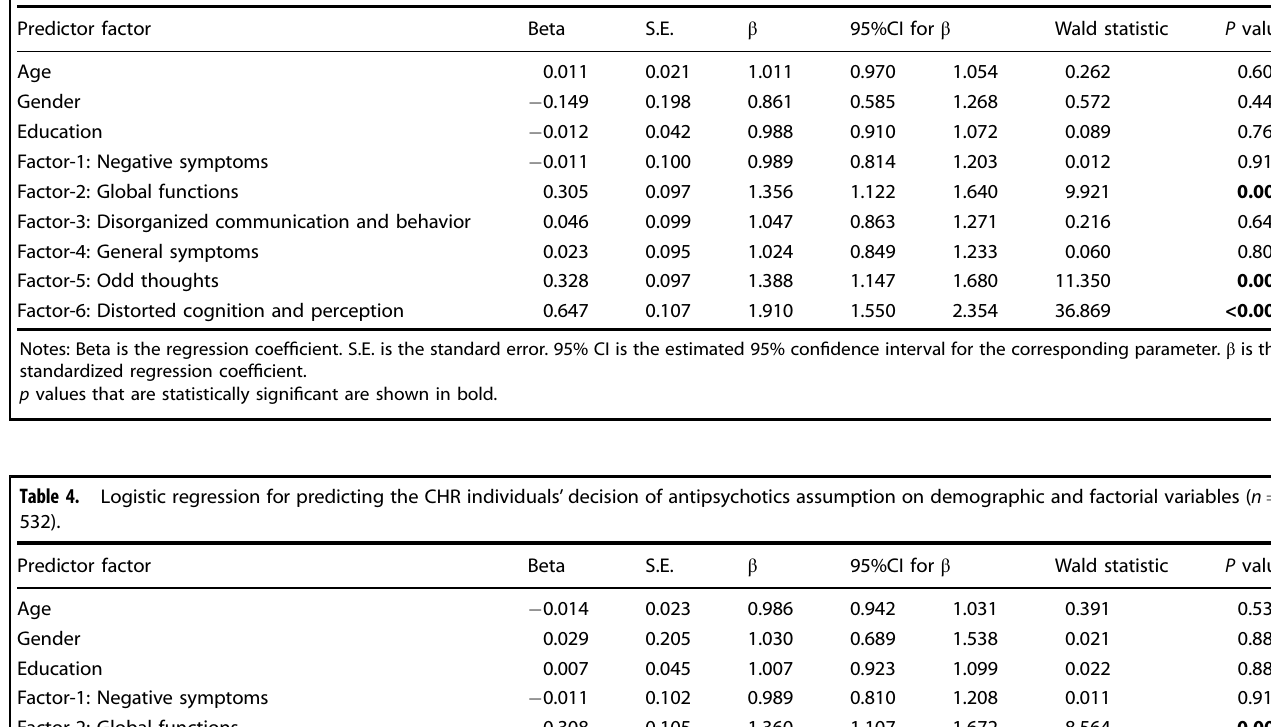
Table 3. Logistic regression for predicting the clinicians ’ decision of antipsychotics prescription on demo8graphic and factorial variables ( n = 600).